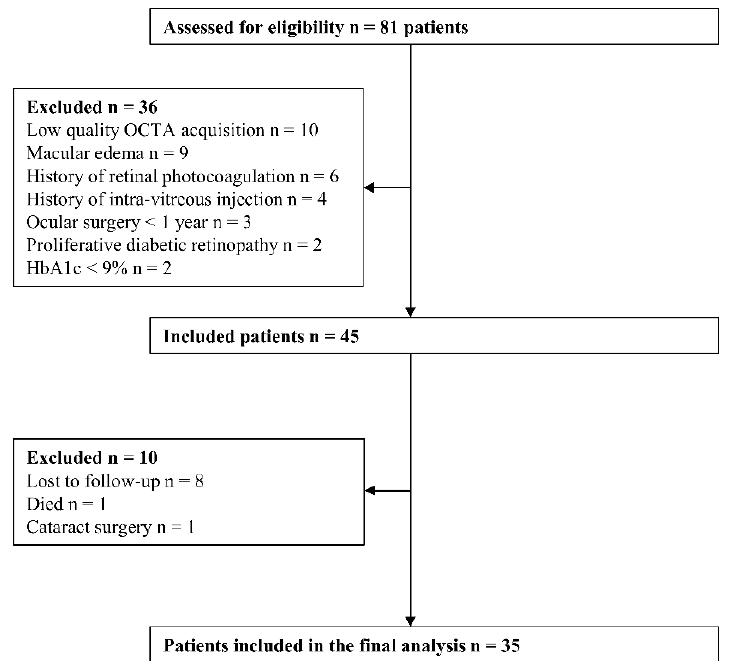
Figure 2. Flowchart of patient eligibility. Table 1. Initial (baseline) characteristics of the diabetic